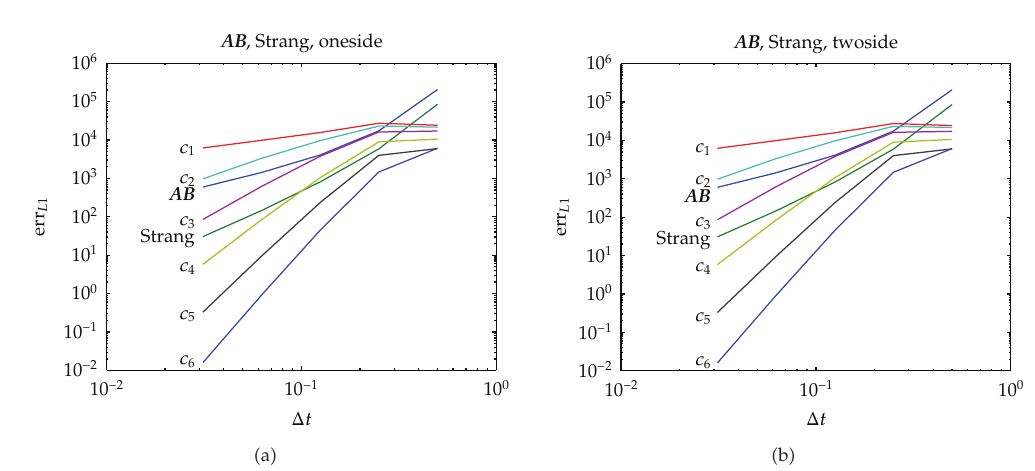
Figure 5: Numerical errors of the standard splitting scheme (cid:5) a (cid:6) and the iterative schemes (cid:5) b (cid:6) with 1 ,... , 6 iterative steps.